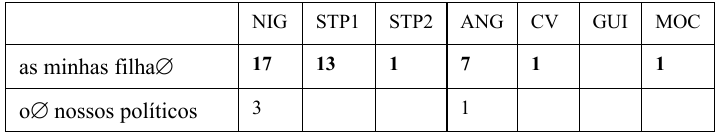
Table 6: Patterns of defective number agreement in the left periphery with more complex NP structures, in all varieties NIG STP1 STP2 ANG CV GUI MOC as minhas filha  17 13 1 7 1 1 o  nossos políticos 3